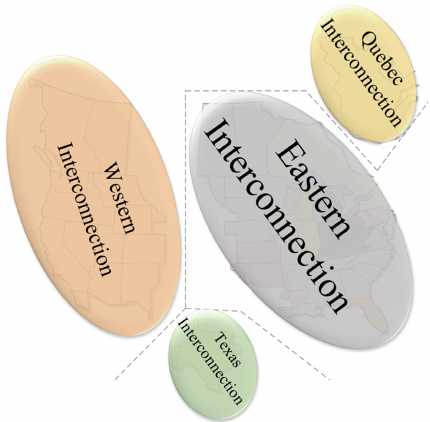
Figure 6. Electric power grid interconnections in North America